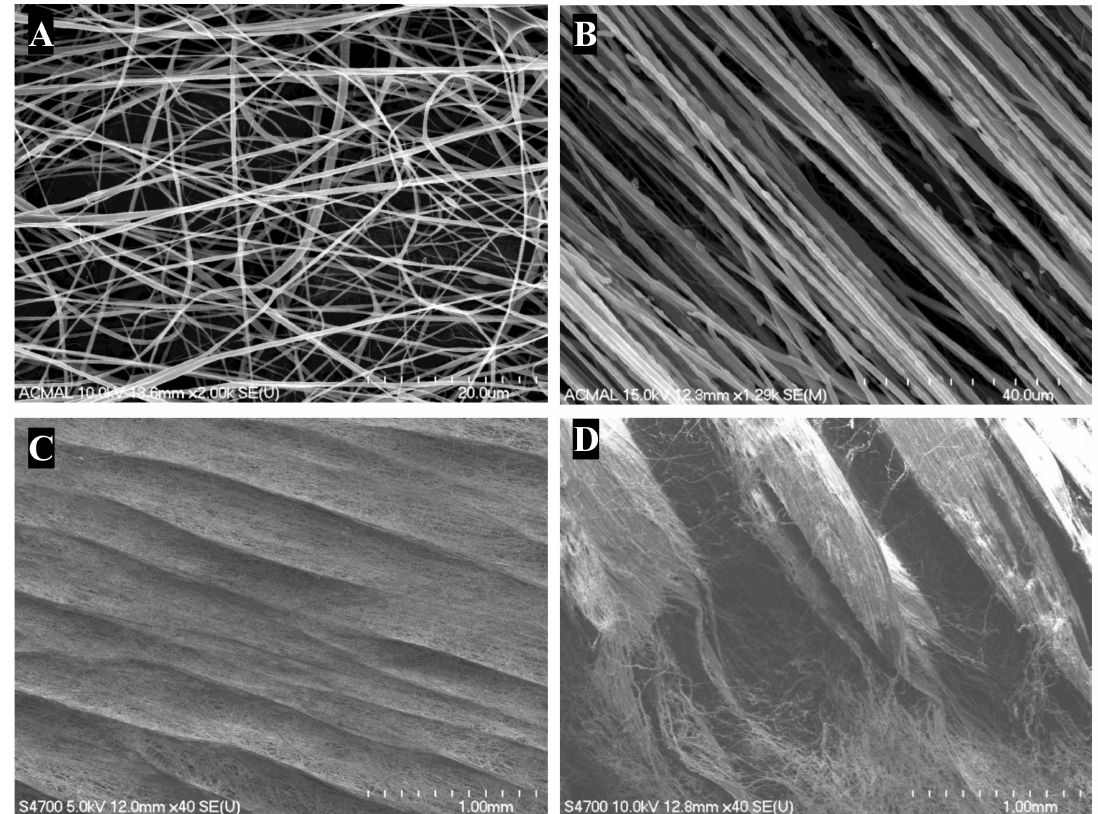
Figure 14. The field emission scanning electron microscope (FESEM) images of the commonly used morphologies for sca ff old tissue engineering fabricated using electrospinning. ( A ) Random morphology composed of randomly oriented fibers ( B ) The aligned morphology consists of layers of identically oriented fibers in a 3D fibrous structure. ( C ) Overlapping morphology is composed of layers of fibers overlapped at regions ( D ) 3D honeycomb structured morphology consists of fibers in a specific arrangement in the sca ff